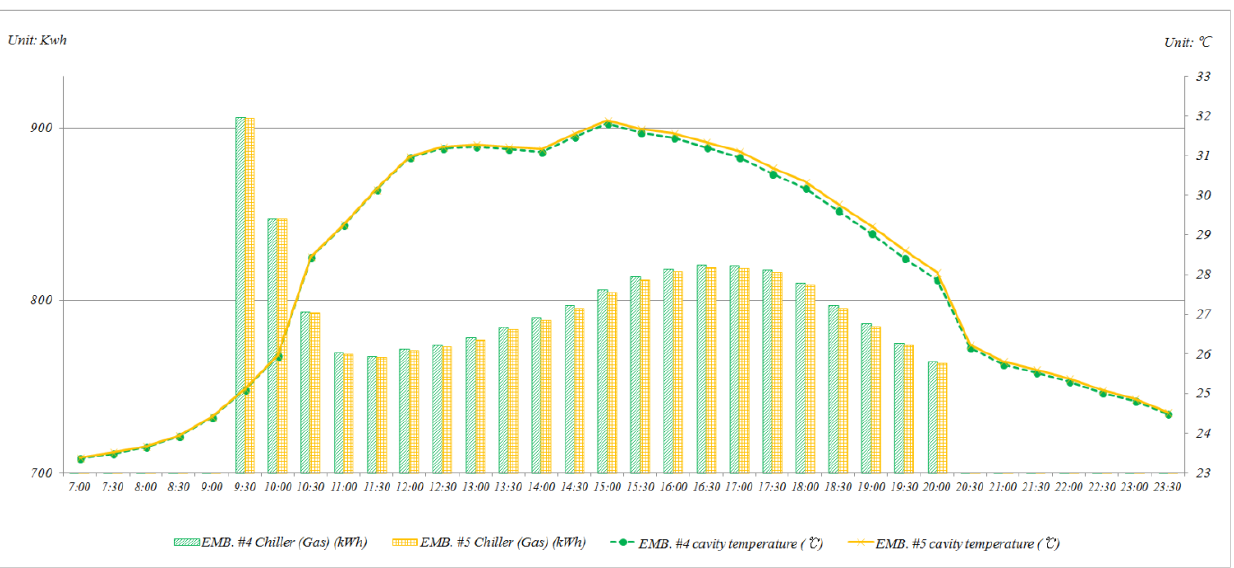
Figure 10 . Temperature-time profile and cooling energy consumption on a summer day (EMB #4 vs. EMB